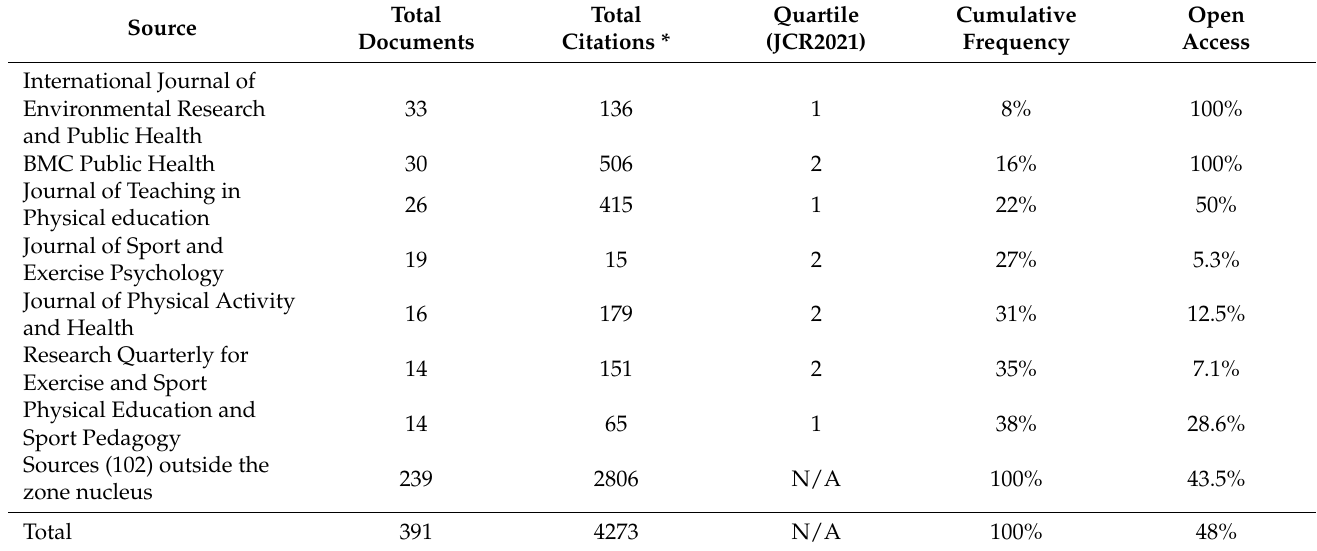
Table 2. Journals with more than 4 publications ranked according to Bradford’s